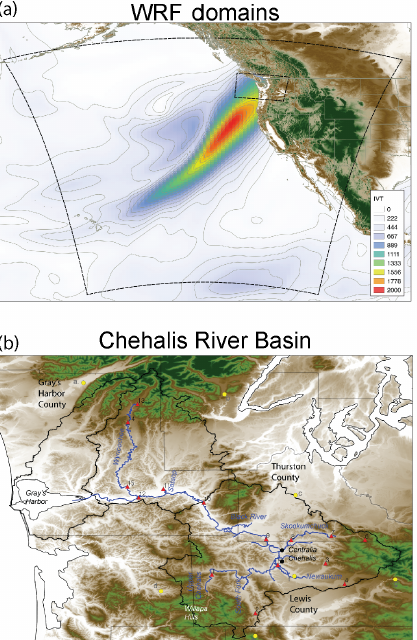
Figure 1. (a) Integrated vapor transport (IVT) kgm − 1 s − 1 on 3 De- cember 2007 from ERA-Interim Reanalysis; dashed lines are the WRF outer and inner domain. (b) Chehalis River basin with to- pographical features and the largest urban areas (Centralia and Chehalis). The Chehalis main channel as represented in HEC-RAS is shown, along with the USGS gauging stations (red triangles) and precipitation stations (yellow circles) used in this study. Numbers correspond to the station information in Table 1.